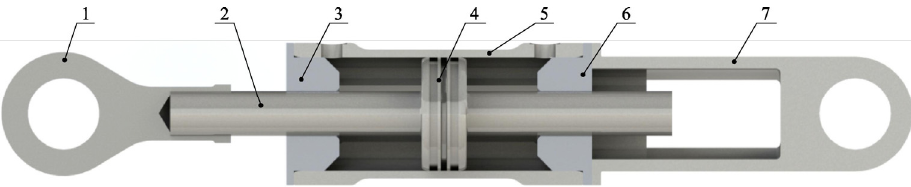
Figure 1. Double tie-rod hydraulic cylinder: 1—front joint, 2—piston rod, 3—front-end cap, 4—piston, 5—barrel, 6—rear-end cap, and 7—tail joint [2].